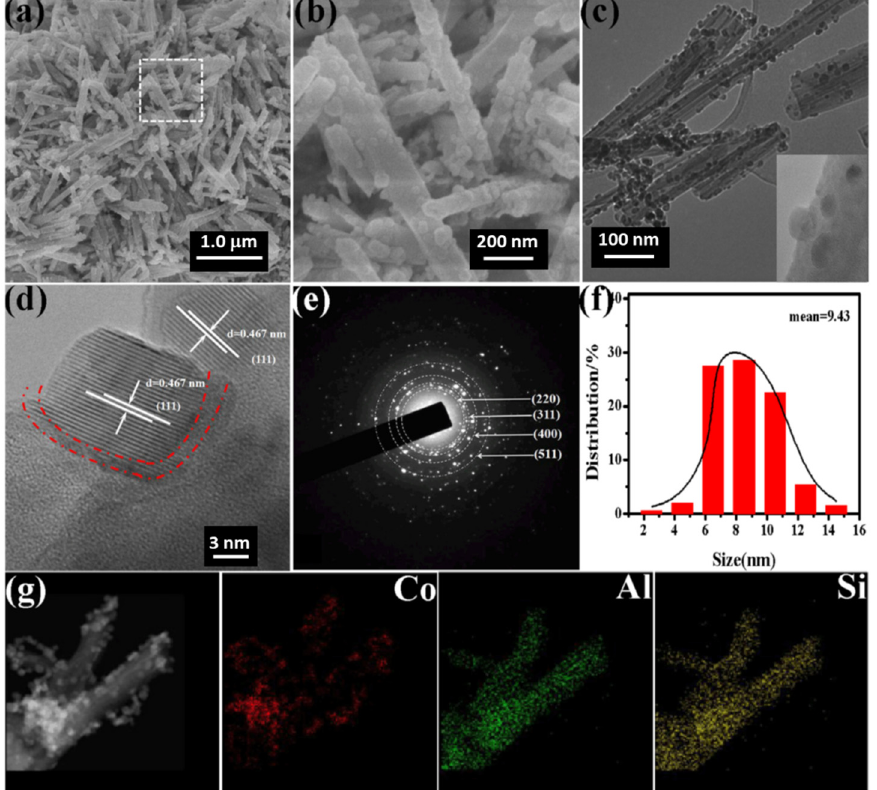
Figure 6. ( a , b ) FESEM images, ( c ) TEM images, ( d ) HRTEM image, ( e ) SAED pattern, ( f ) Particle size distribution and ( g ) EDX elemental mapping images of Co 3 O 4 /HNTs nanomaterial. Reproduced with permission from ref. [83]. Copyright 2021